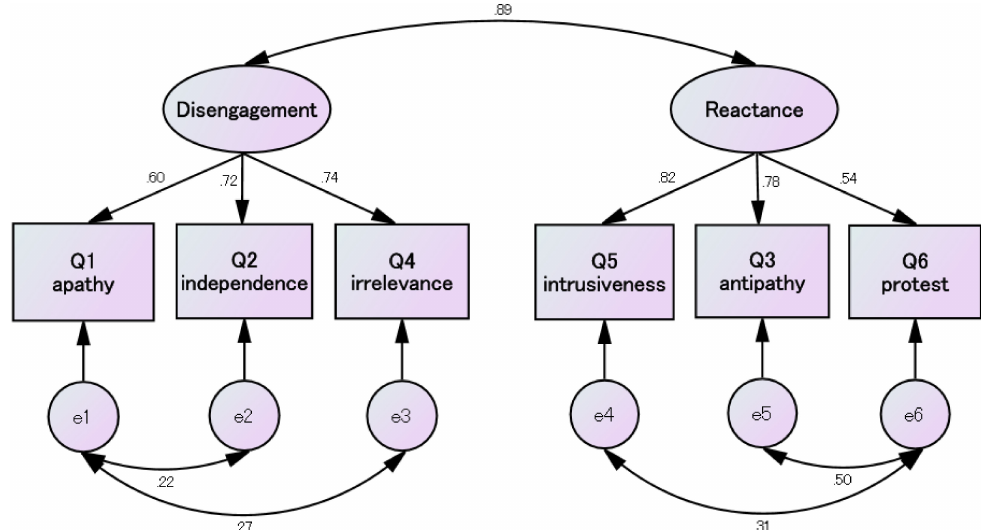
Fig. 1 Path diagrams of the two-factor model Rectangles are observed variables (items); ellipses are latent variables (factors); values on the single-headed arrows are standardized factor loadings; and values on the double-headed arrows are correlation coe ffi cients. Model fi tness: chi-square 18.691 (df 4) p < 0.001, comparative fi t index = 0.998, standardized root mean square residual = 0.011, root